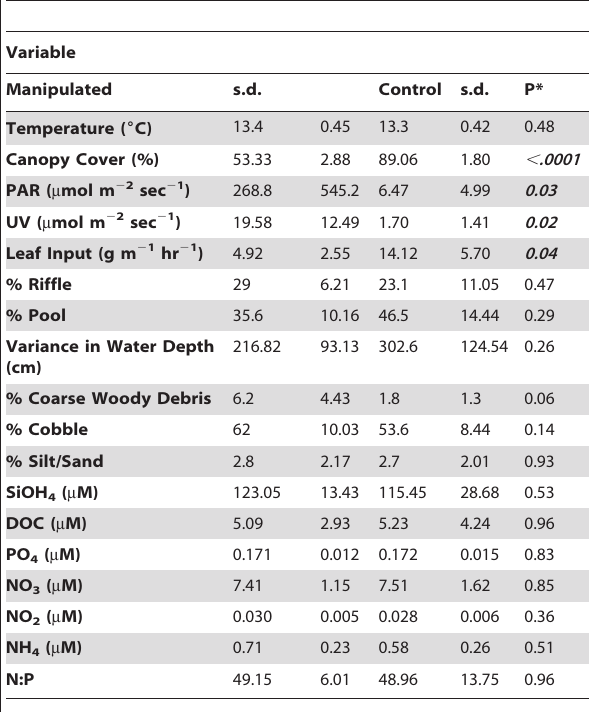
*Statistical comparisons based on paired t-tests. N=5 per